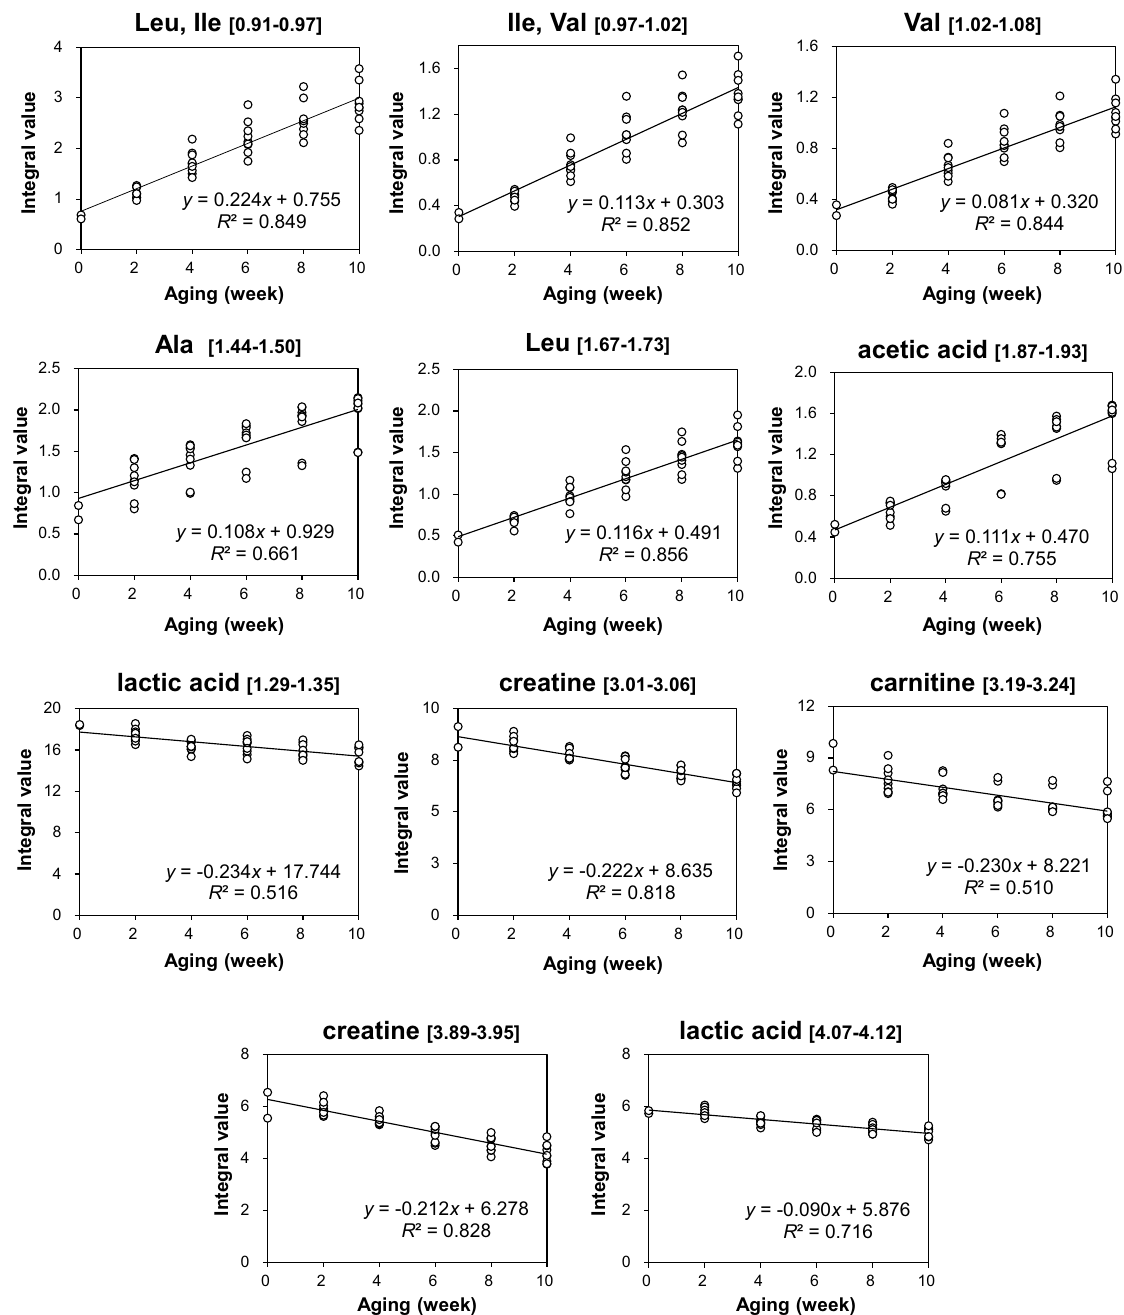
Figure 5. Changes in the contents of aging-related compounds, which are given as the integral values of individual buckets. The square brackets represent the chemical shift range of each spectral bucket, which is labeled by the assigned compound